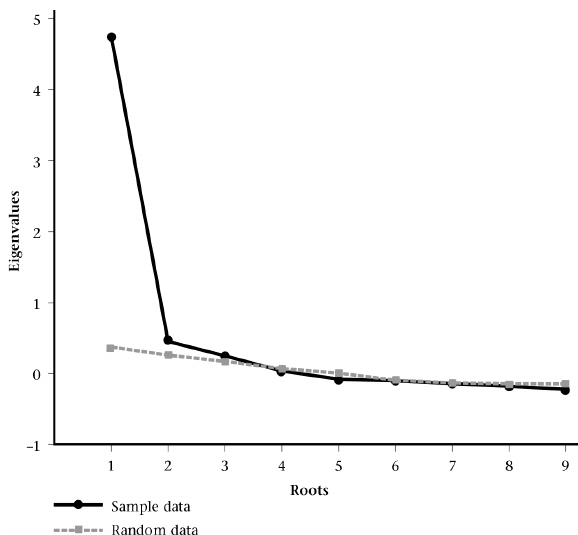
Figure 1. Scree plot and parallel analysis plot for Group 1